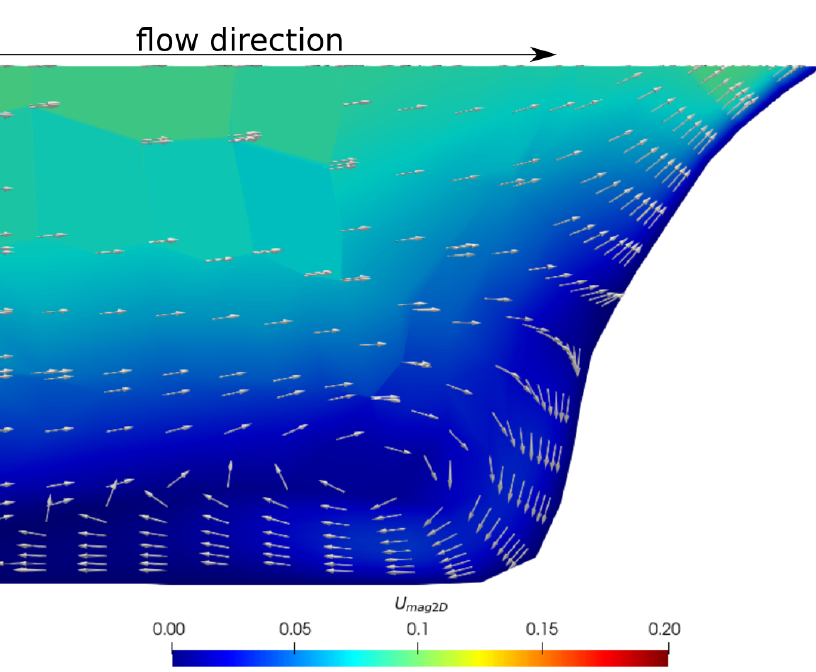
Figure 15. Comparison of the values of C f between RIB-1 with values from Campet et al. [19] and RIB-2.